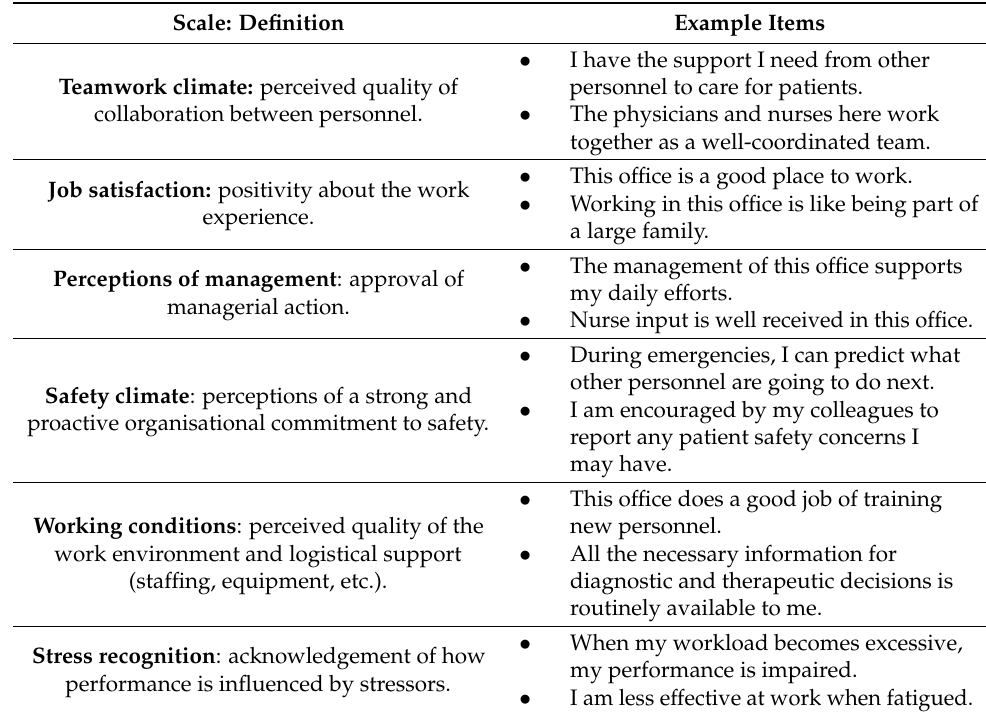
Table 1. SAQ factor definitions and example items